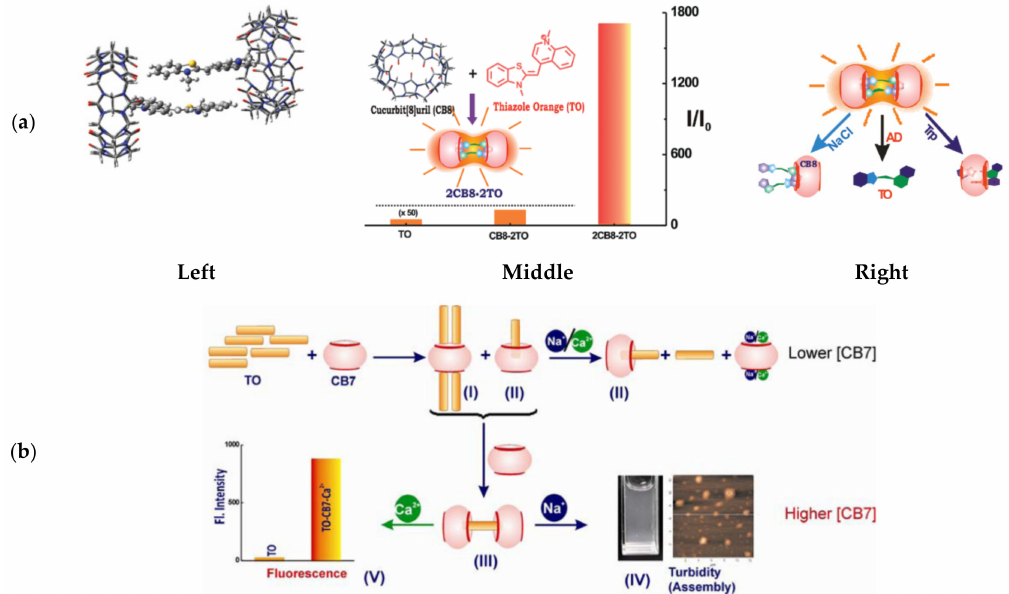
Figure 9. Examples of TO’s interactions with cucubit[n]uril host molecules. ( a ) Left: The structure of a formed 2:2 complex between CB8 and TO. Middle: Complex formation resulted in a 1700-fold increase in TO dimer fluorescence. Right: examples of nonemissive species generated in response to the presence of different analytes. Reproduced with permission from [133]. Copyright 2012 American Chemical Society. ( b ) Different CB7-TO complexes formed under different environments, displaying distinct responses to either sodium or calcium ions. Reproduced with permission from [134]. Copyright 2015 American Chemical